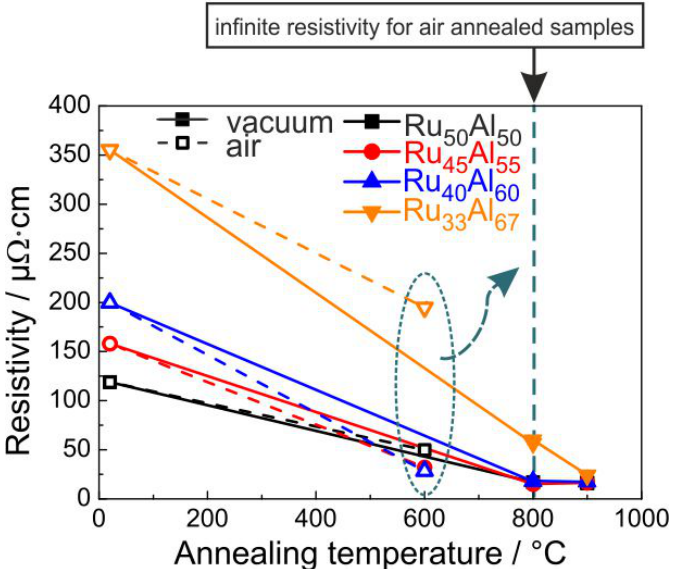
Figure 9. Electrical resistivity of the samples with the different compositions after annealing under high vacuum conditions (solid line) and air (dashed line); measured at RT. All films annealed in air at 800 ◦ C showed an infinite